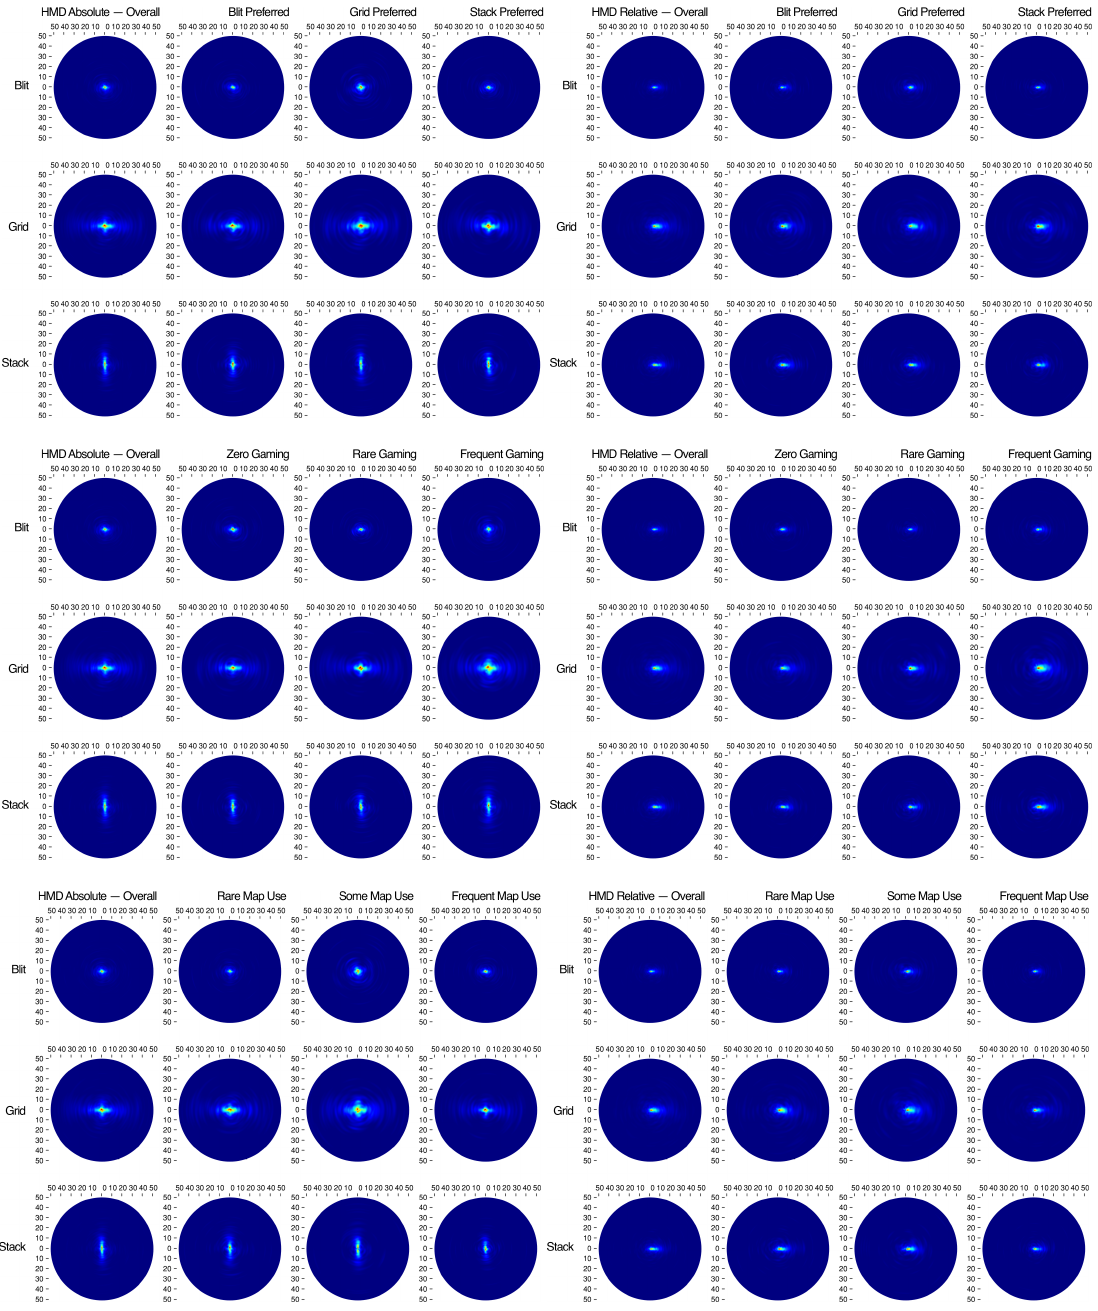
Figure A4. Polar plots showing the density probability distributions of absolute and relative saccades of the head—the HMD movement component—in degrees, represented as polar plots, for each MCV system (blit/grid/stack) and subgrouped by the participants’ preference for an MCV system regarding its legibility ( top ), the frequency with which they play video games ( middle ), and the frequency with which they consult city maps ( bottom